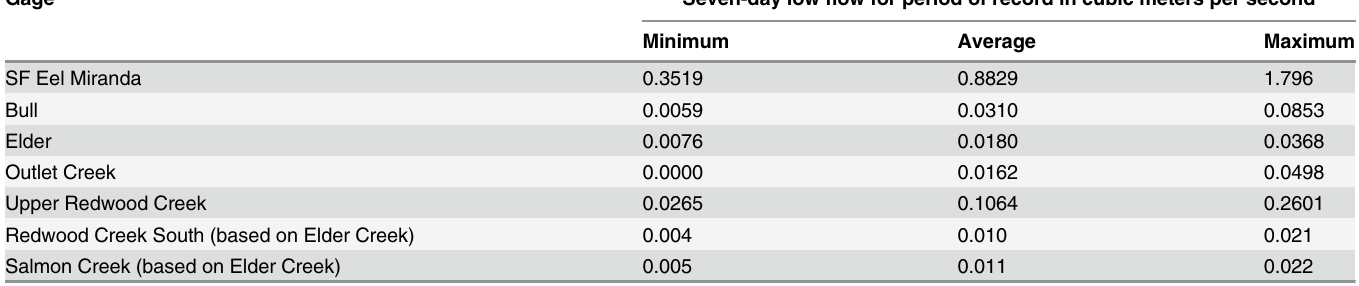
Table 2. Annual seven-day low fl ow range for period of